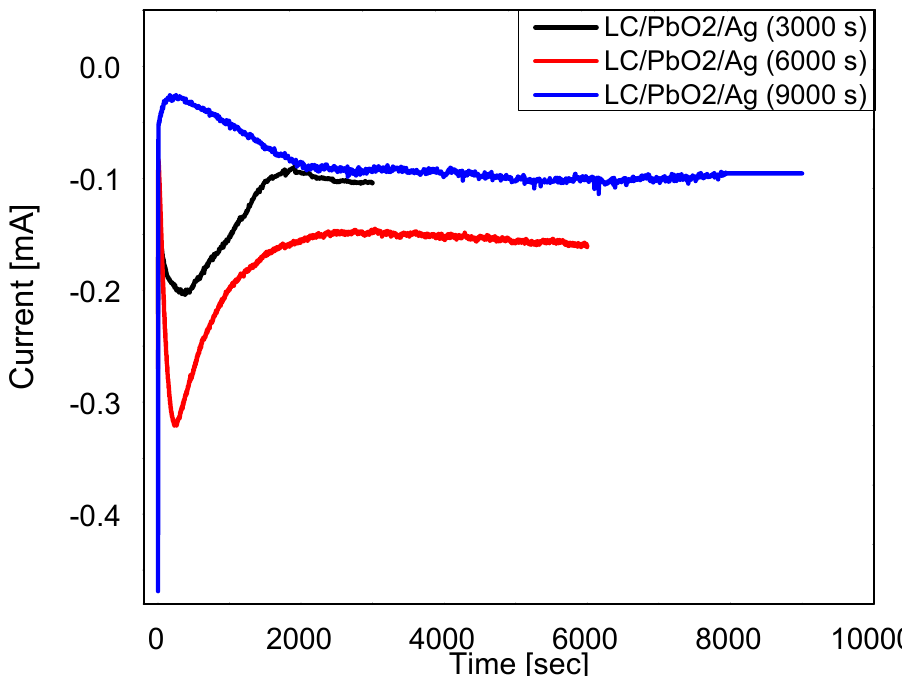
Figure 1. Electrodeposition curves of LC \ PbO2 \ Ag for 3000 s, LC \ PbO2 \ Ag for 6000 s, and LC \ PbO2 \ Ag for 9000 s.